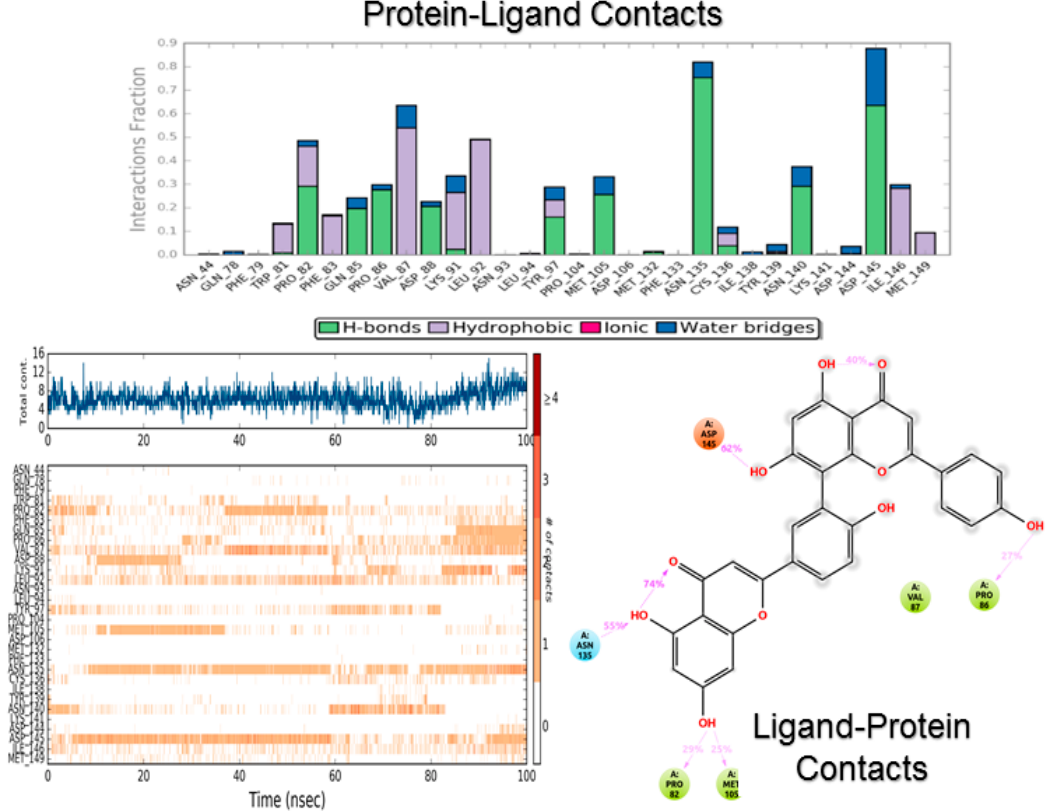
Figure 7. Protein–ligand contact analysis for amentoflavone during the molecular dynamics (MD) simulation.